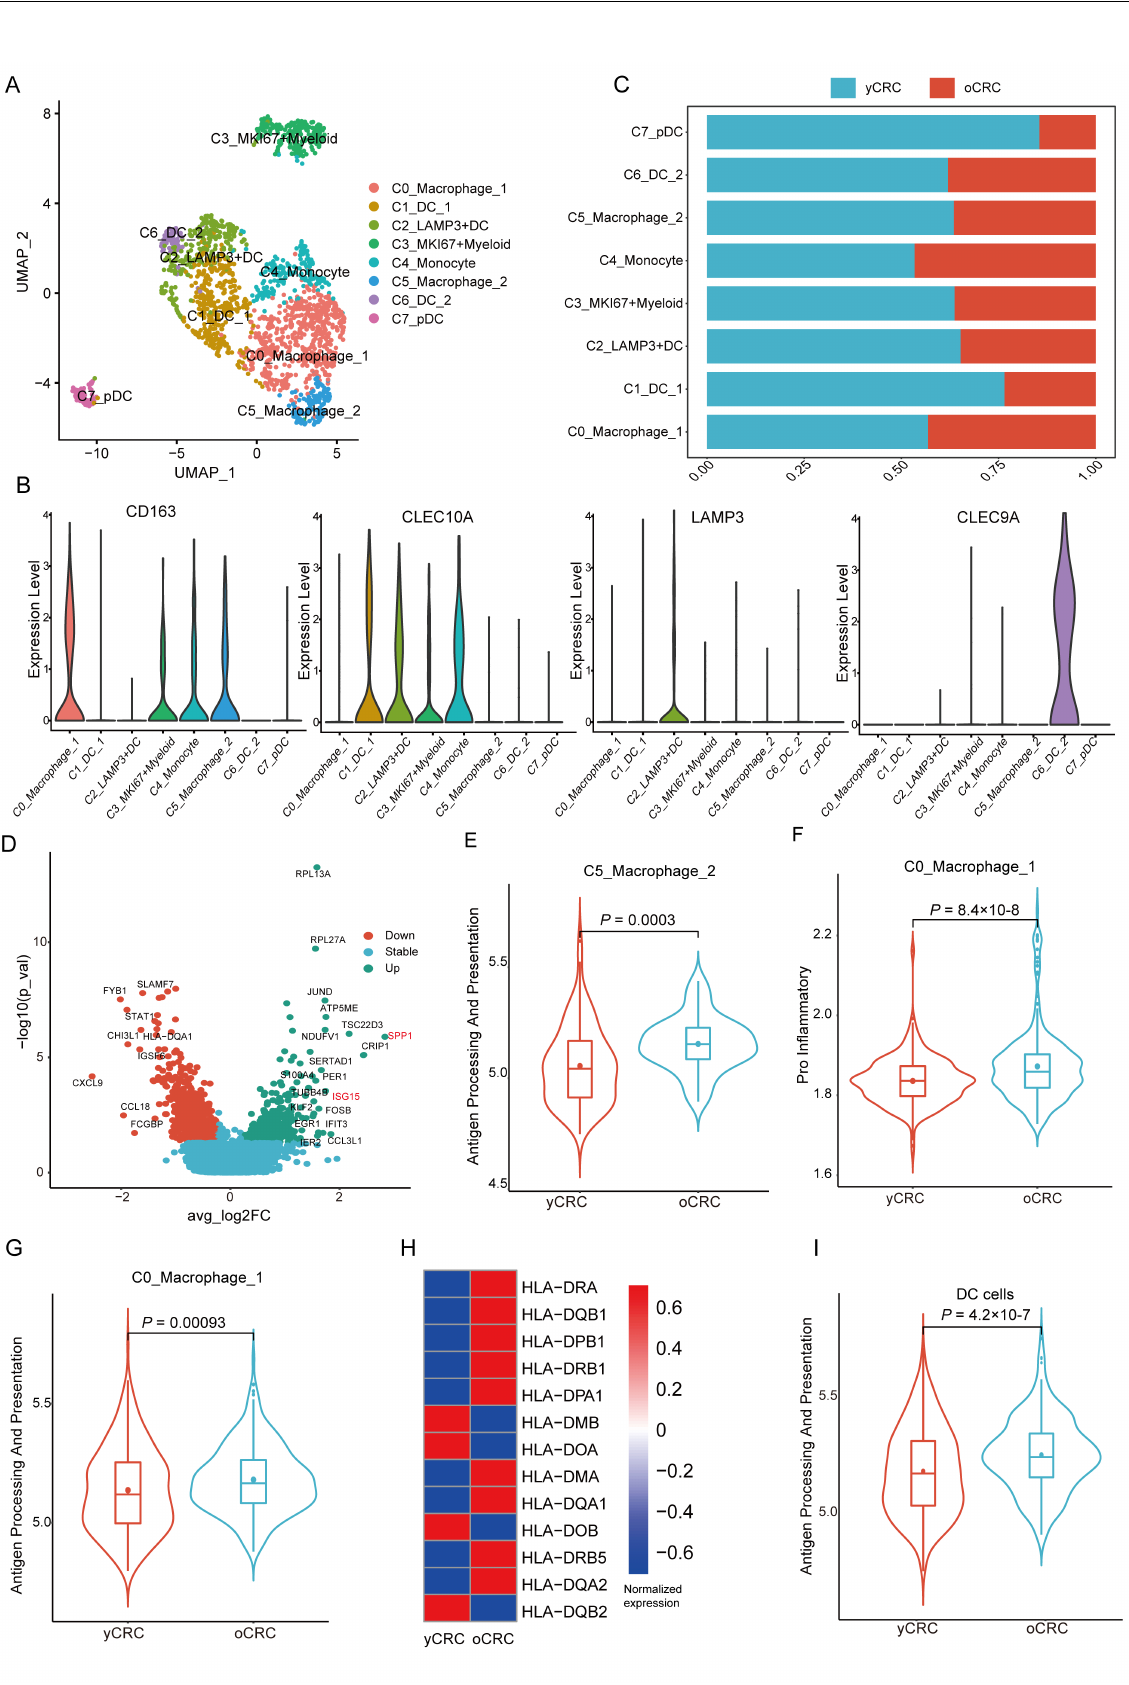
Figure 5. Myeloid cells in yCRC and oCRC. ( A ) UMAP plot showing the subgroups of myeloid cells. ( B ) Violin plot showing the high expression marker genes of myeloid cell subtypes. ( C ) The bar